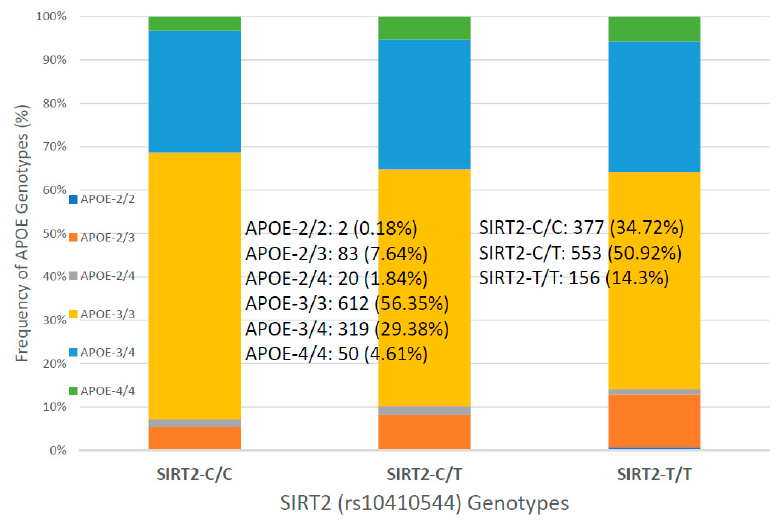
Figure 4. Distribution and frequency of APOE genotypes among carriers of major SIRT2 (rs10410544) variants.